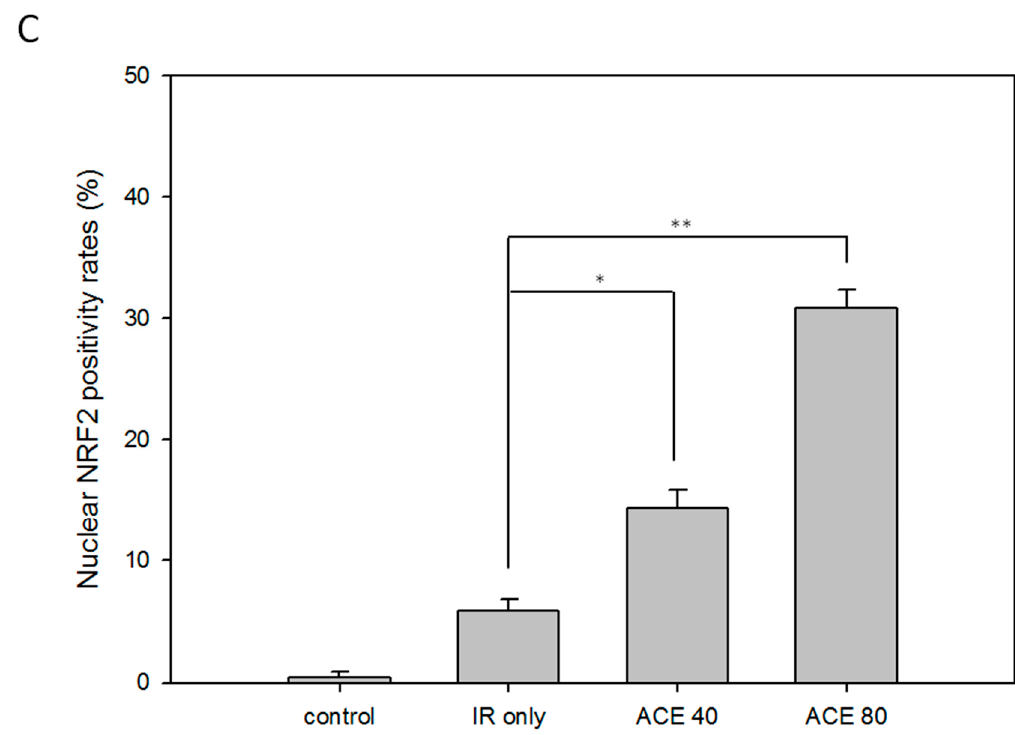
Figure 6. Enhancement of the irradiation-induced nuclear factor erythroid-2-related factor (Nrf2) expression and nuclear translocation by ACE treatment. With or without ACE pre-treatment for 16 h, CL48 cells were irradiated with a dose of 15 Gy and harvested 24 h later for Western blot ( A ) and immunofluorescence staining ( B , left) of Nrf2. The slides were counterstained with 4 ′ ,6-diamidino-2-phenylindole (DAPI) (300 nM in PBS) ( B , middle) and merged images ( B , right). ( C ) The nuclear Nrf2 positivity rates were plotted. Results were obtained from random fields of three independent experiments for each group. *, p < 0.05; **, p < 0.01, as compared with the IR only group.